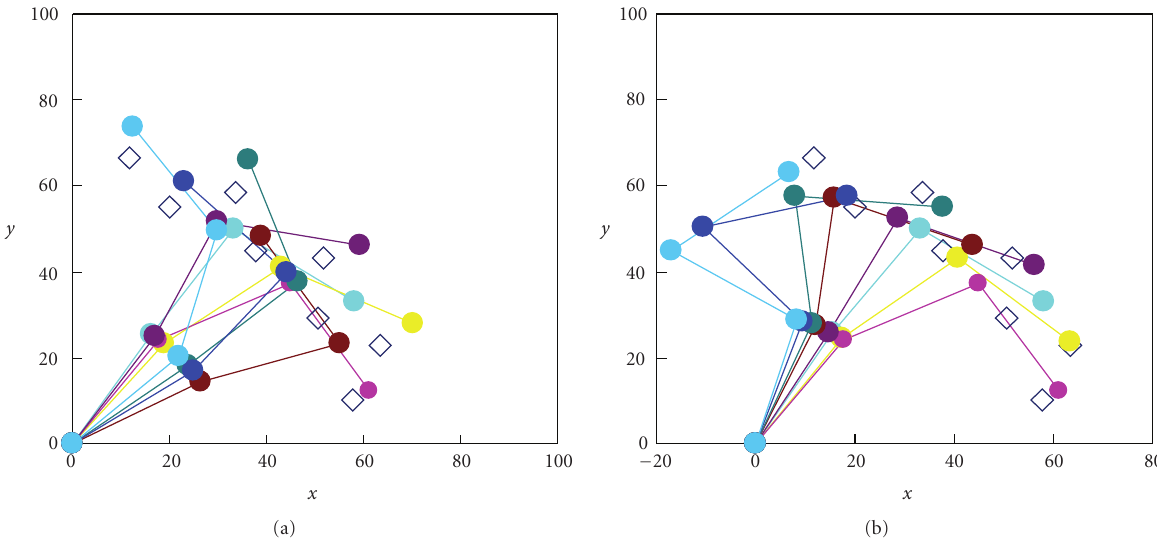
Figure 11: Graphs showing the coordinates of robot arm whose joint angles are estimated by network inversion (a) with regularization F 3 ( x ) and (b) without regularization for ill-posed problem of